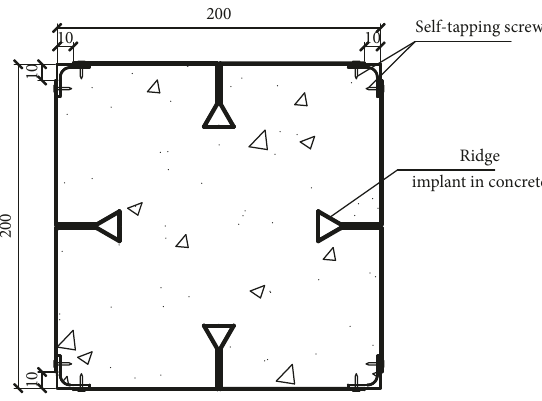
Figure 20: B-type